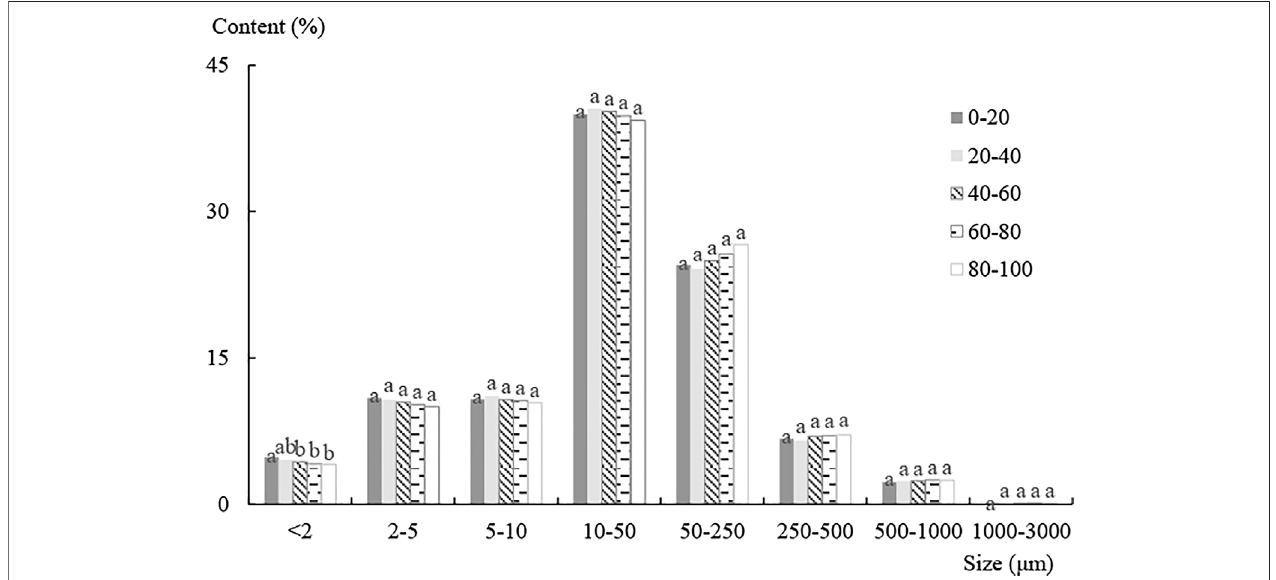
FIGURE 1 | Average percentage distribution of the soil particles in the region. [Different lowercase letters indicate signi fi cant difference in the content of the same particle size in the soil pro fi le ( p < 0.05)].